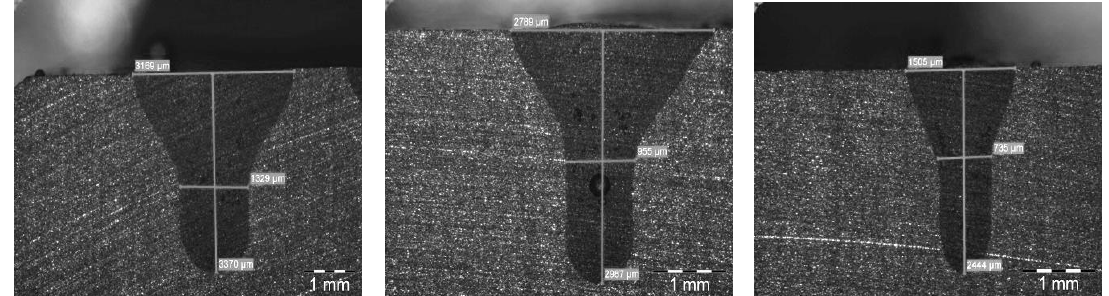
Figure 2. From left to right : Cross ‐ section views for DISPAL S220 for welding velocities of 3, 5 and 10 m/min for P = 3 kW and a focal position of F = 0 mm. For 3 m/min the positions of EDX measurements are marked for base material, transition zone and weld seam.